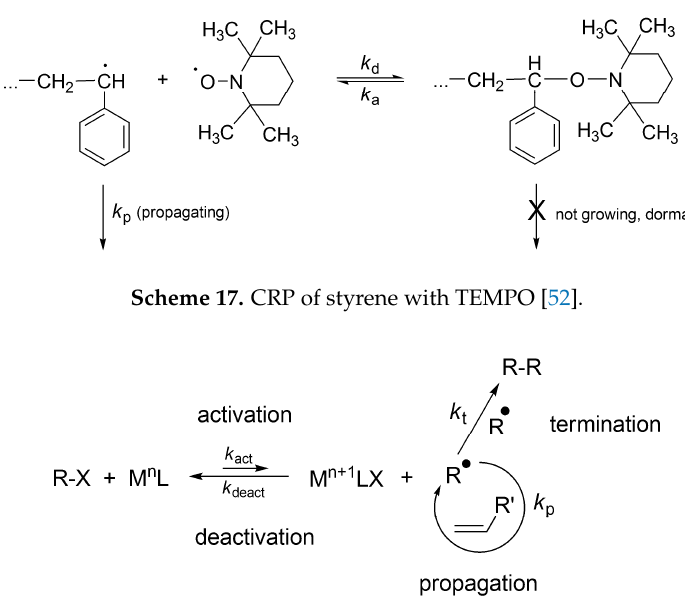
Scheme 18. Schematic illustration of the key reactions in ATRP. (L stands for ligand—mostly derivatives of amines, and M is Cu on the oxidation state n or n +